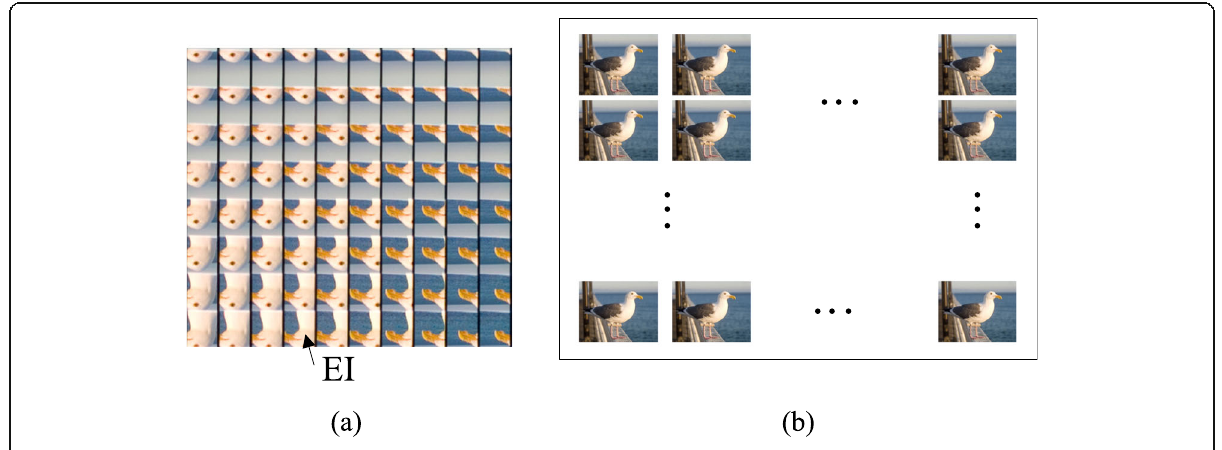
Fig. 2 Acquired light-field image seagull : a lenslet image. b 4D LF view